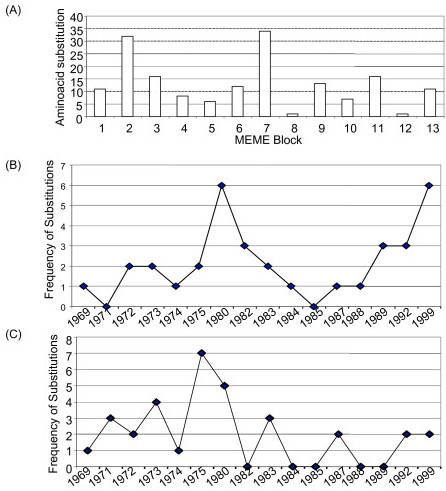
Number of aminoacid substitutions in each MEME block over the period from 1968–1999. (A) Bar graph of amino acid substitutions within MEME blocks for each of the years. (B) Behavior of the substitutions in MEME block 7; frequency of amino acid substitutions within MEME block 7 largely follows the occurrence pattern of substitutions within the entire protein as illustrated Table 2, reaching a peak in 1980, which corresponds to the year with the greatest number of mutations in the alignment. (C) Behavior of the substitutions in MEME block 2.